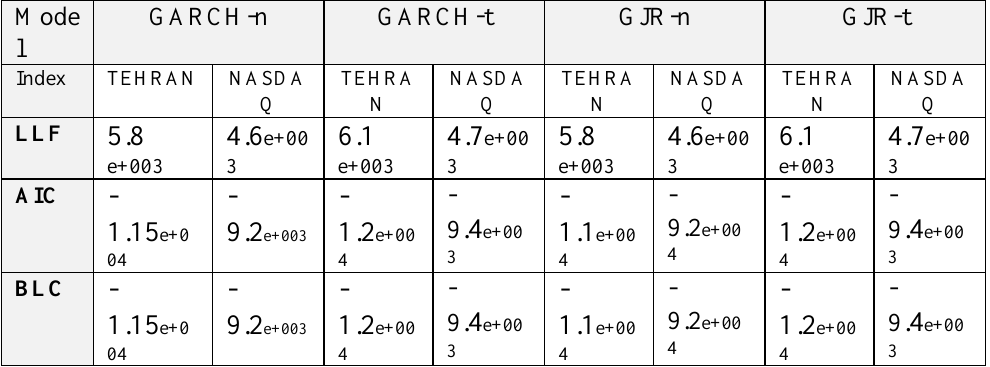
Table 2. Estimation GARCH-GJR model and statistic